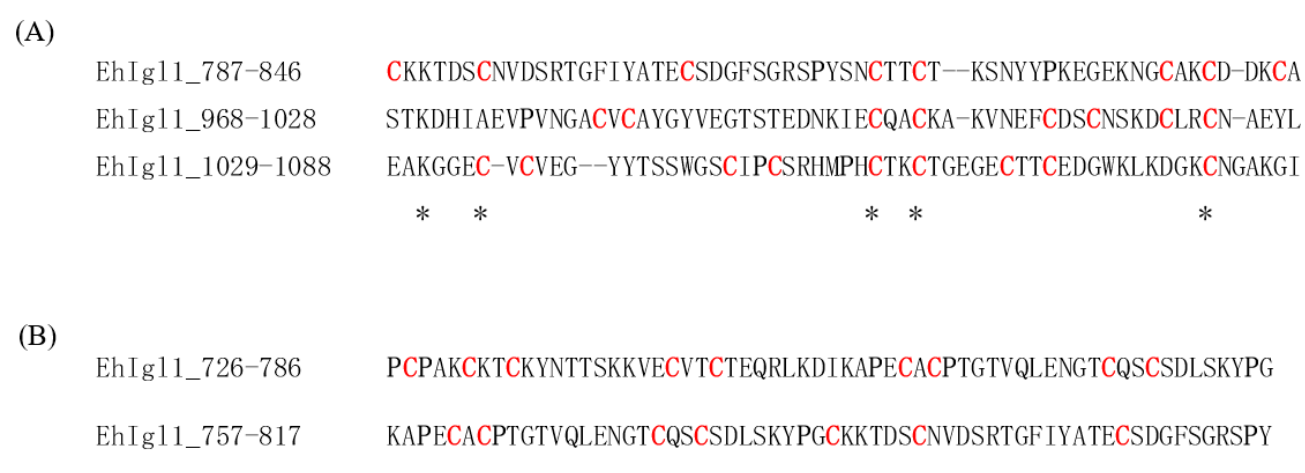
Figure 6. Amino acid sequences of Igl1 fragments. ( A ) Sequence alignment of Igl1 fragments with hemolytic and cytotoxic activities. Asterisks indicate common amino acids. ( B ) Sequences of Igl1 fragments without these activities. The Igl1 sequence refers to protein ID AAK92361. Cysteine residues are shown in red and proline residues are shown in bold.